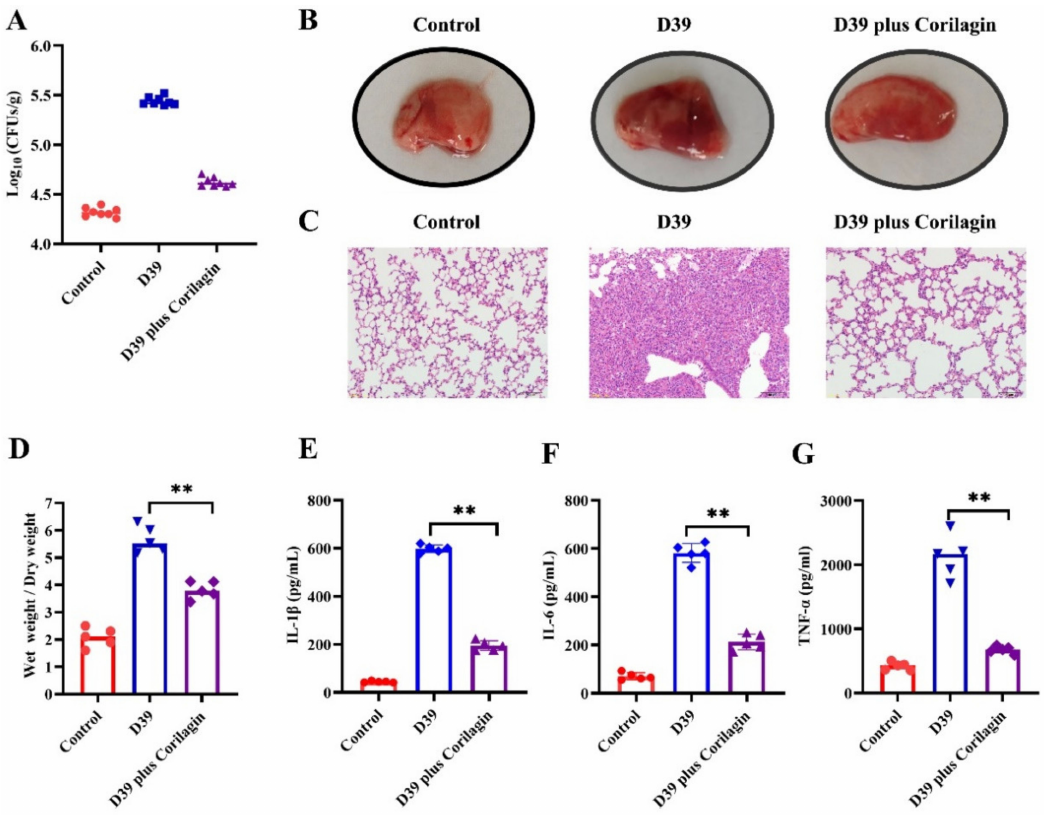
Figure 4. Corilagin effectively protected mice from S. pneumoniae D39 infection. The mice were infected with S. pneumoniae intranasally and, thereafter, were treated with or without corilagin (50 mg/kg). After 96 h of infection, the bacterial burden of the lung ( A ) was calculated and the photographs of the ocular pathological changes of the lung ( B ) were displayed after the mice died via dislocation. Then, the haematoxylin and eosin staining slices ( C ) presented the histopathological changes of the lung. Then, ( D ) the wet/dry weight ratio of lung tissue and the levels of IL-1 β ( E ), IL-6 ( F ) and TNF- α ( G ) in the bronchoalveolar lavage fluid (BALF) were all detected to assess the efficacy of corilagin for S. pneumoniae -infected mice. ** p <